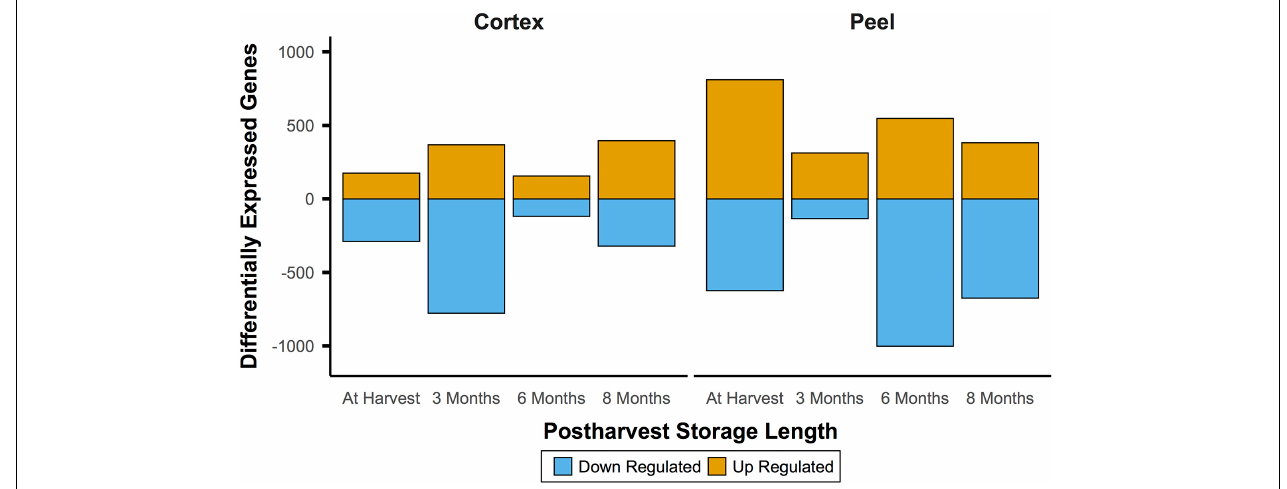
FIGURE 4 | Gene expression between canopy positions suggests a persistent effect of phased at-harvest fruit maturity. Gene expression for both tissue types was of a fairly consistent magnitude throughout the experiment, which spanned 8 months of controlled atmosphere storage at − 0.5 ◦ C. This contrasts with the initially large and waning magnitude of patterns of differential expression through time in storage, and indicates the possibility that gene expression signatures may be useful to predict fruit quality at and after harvest. Significant differential expression determined by Bonferroni corrected P < 0.05.